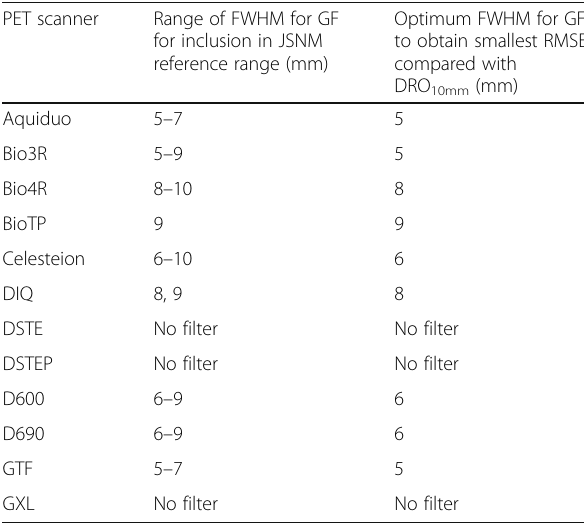
Table 2 Full-width at half maximum for SUV harmonization of PET scanners